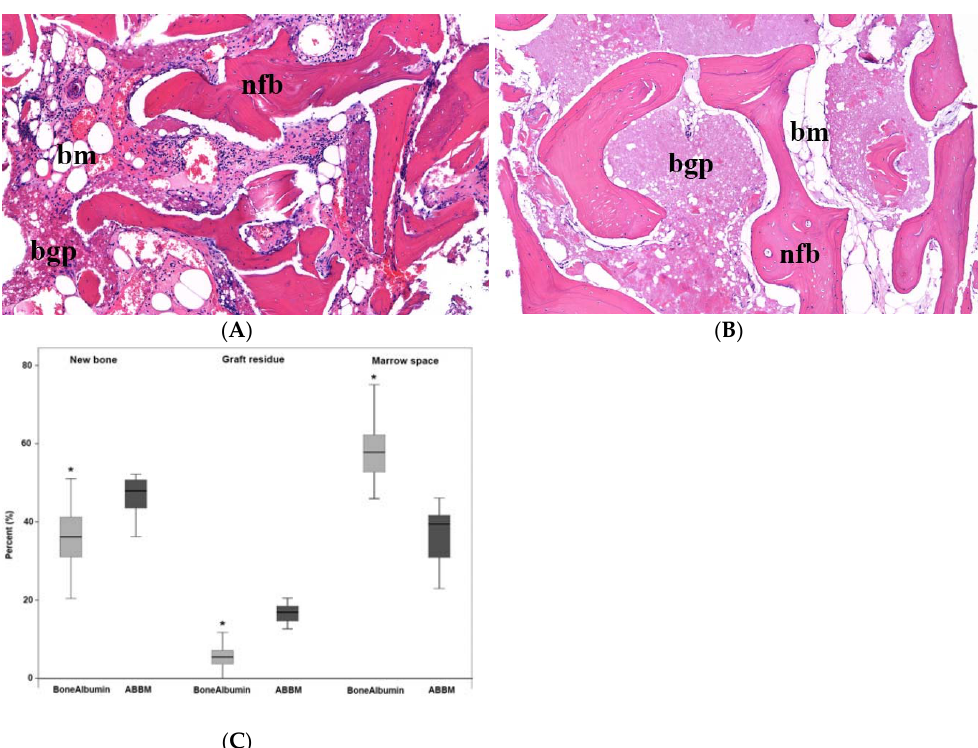
Figure 2. Histological assessment of the graft and the newly formed bone tissue. ( A ) A